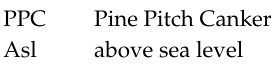
Table S1: Summary of the selected GLM models for each of the three symptoms in each of the four variables groups, according to AIC. Only models with a difference between their AIC and the best fitting model lower than two are shown, Table S2: Summary of the Pearson residual against the fitted model